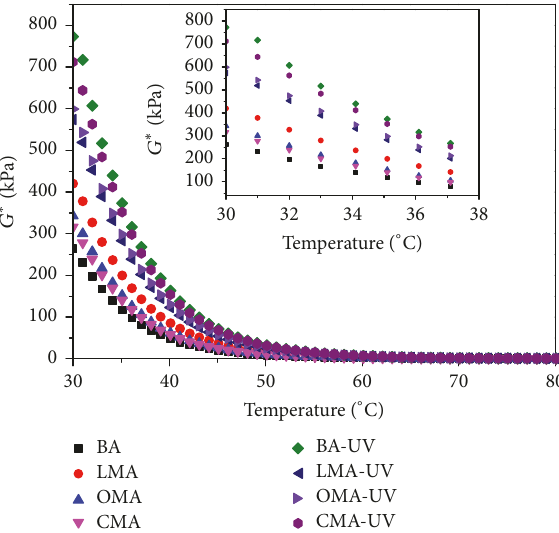
Figure 10: 𝐺 ∗ of UV aged and unaged asphalt from 30 ∘ C to 80 ∘ C.